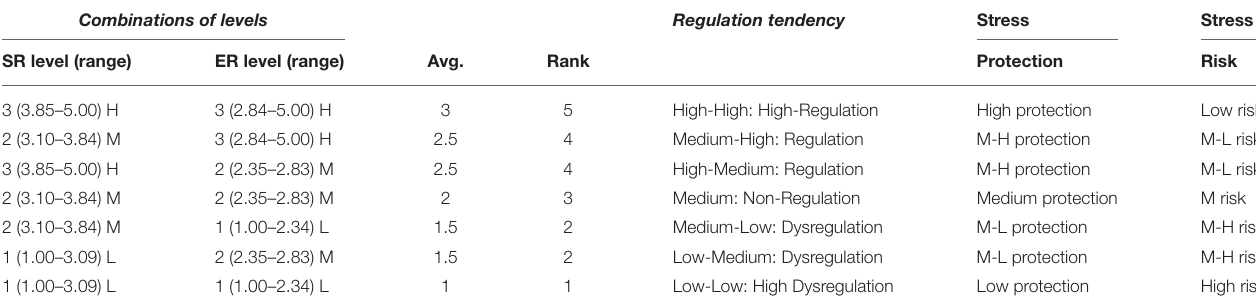
TABLE 2 | Combinations of model parameters hypothesized by SR vs. ER Theory (de la Fuente, 2017, 2021a,b). Combinations of levels Regulation